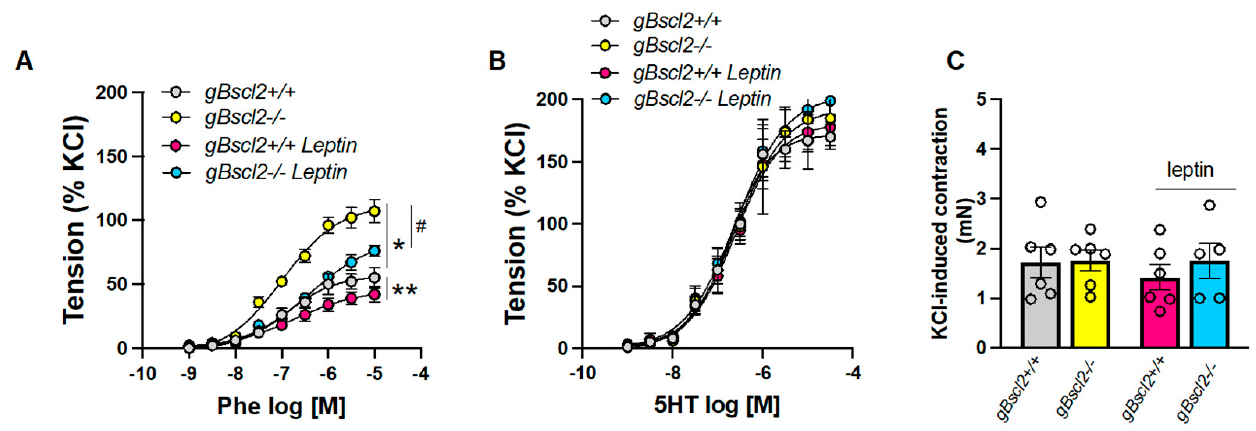
Figure 1. Leptin treatment reduces vascular adrenergic contractility in aortas from lipodystrophic mice. Concentration response curves to phenylephrine ( A ), serotonin ( B ) and KCl ( C ) in aortic rings from wild type (gBscl2 +/+ ) or Bscl2 deficient mice (gBscl2 -/- ) treated or not with leptin (0.3 mg/kg/day for 1 week, via osmotic mini-pump). Data are presented as mean ± S.E.M. N = 4–7; * p < 0.05 gBscl2 +/+ vs. gBscl2 -/- ; ** p < 0.05 gBscl2 +/+ vs. gBscl2 +/+ + leptin; # p < 0.05 gBscl2 -/- vs. gBscl2 -/- + leptin.